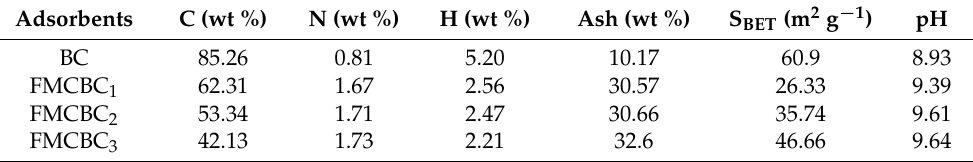
Table 1. Physicochemical properties of the FMCBCs.